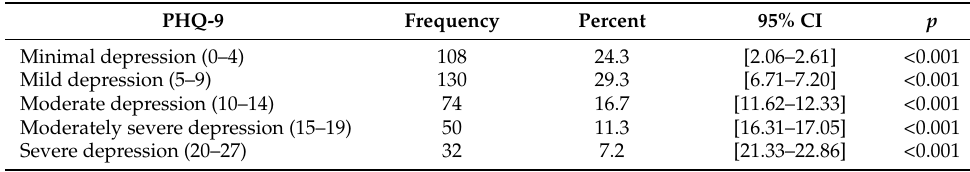
Table 2. The frequencies of the PHQ-9 self-reported